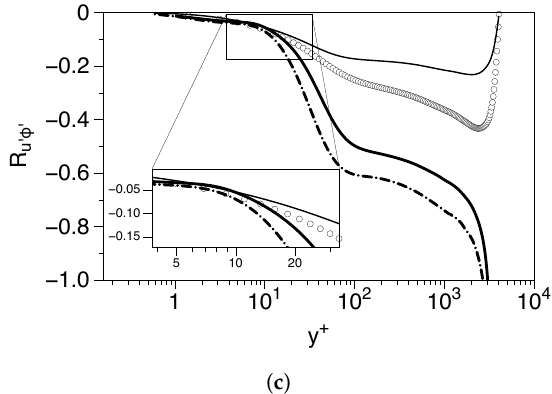
Figure 5. Model predictions for the scalar ratio R u (cid:48) φ (cid:48) for a Poiseuille flow at ( a ) Re τ = 395, ( b ) Re τ = 995, and ( c ) Re τ = 4088. Comparison is made with DNS predictions for the stress ratio R 12 / R 11 (thin lines) and the scalar ratio (symbols). The thick solid line denotes the proposed model and the dash-dotted line denotes Younis’ model. Zoomed view refers to the near-wall region.